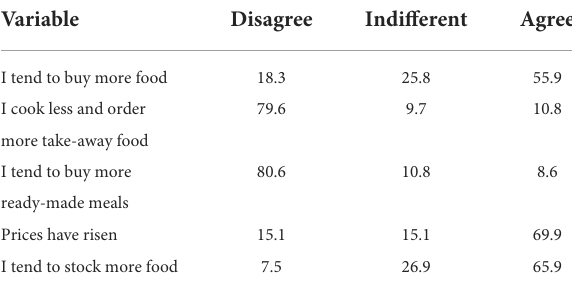
TABLE 8 Summary statistics of the main reasons for increased food storage at